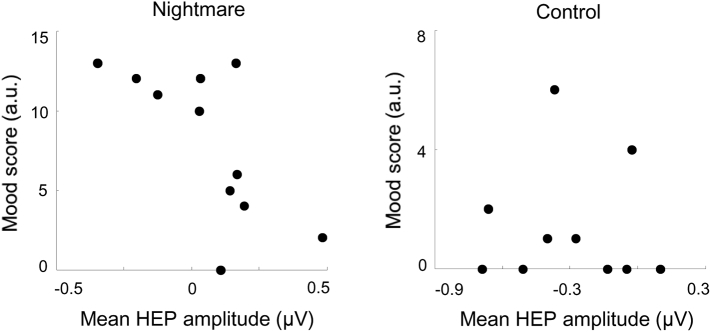
Mood score as a function of the mean HEP amplitude in the frontal cluster. Across participants, BDI score negatively correlated with the mean HEP amplitude within the significant cluster in the nightmare group (left, τ = −0.50, p = .03), but not in the control group (right, τ = −0.05, p = .84). Each dot indicates a subject.